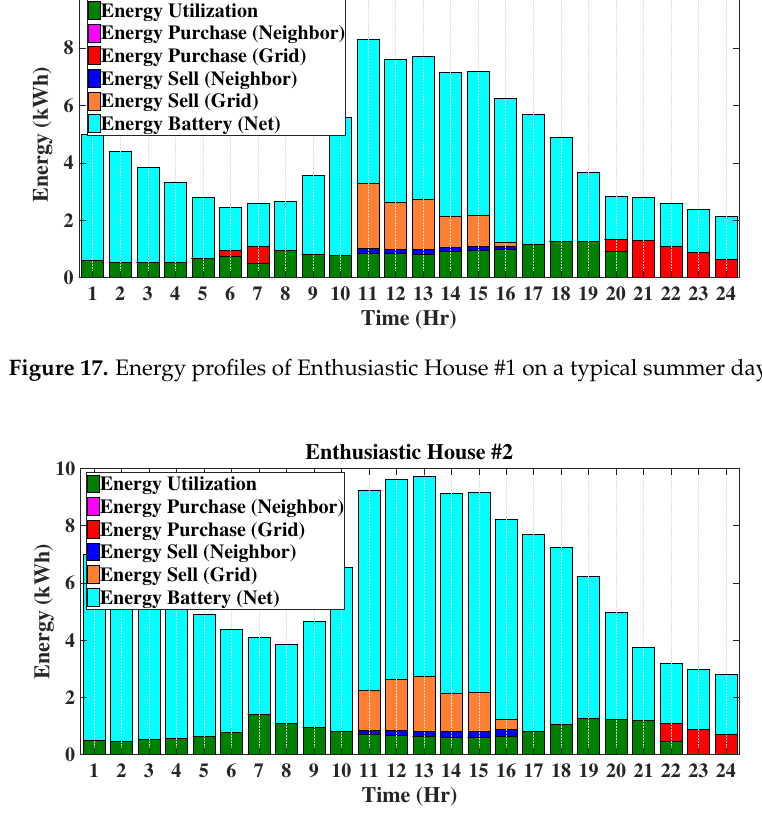
Figure 18. Energy profiles of Enthusiastic House #2 on a typical summer